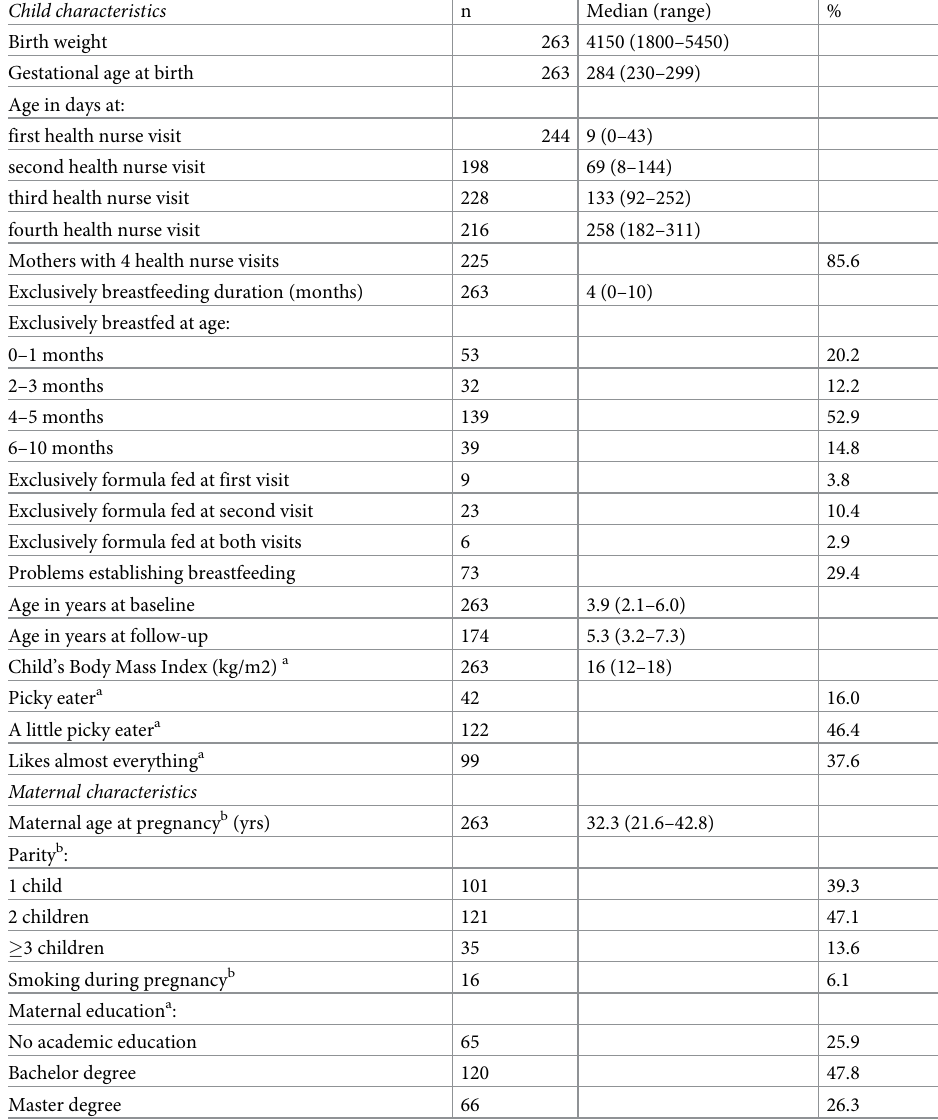
Table 1. Characteristics of the mother and child. Child